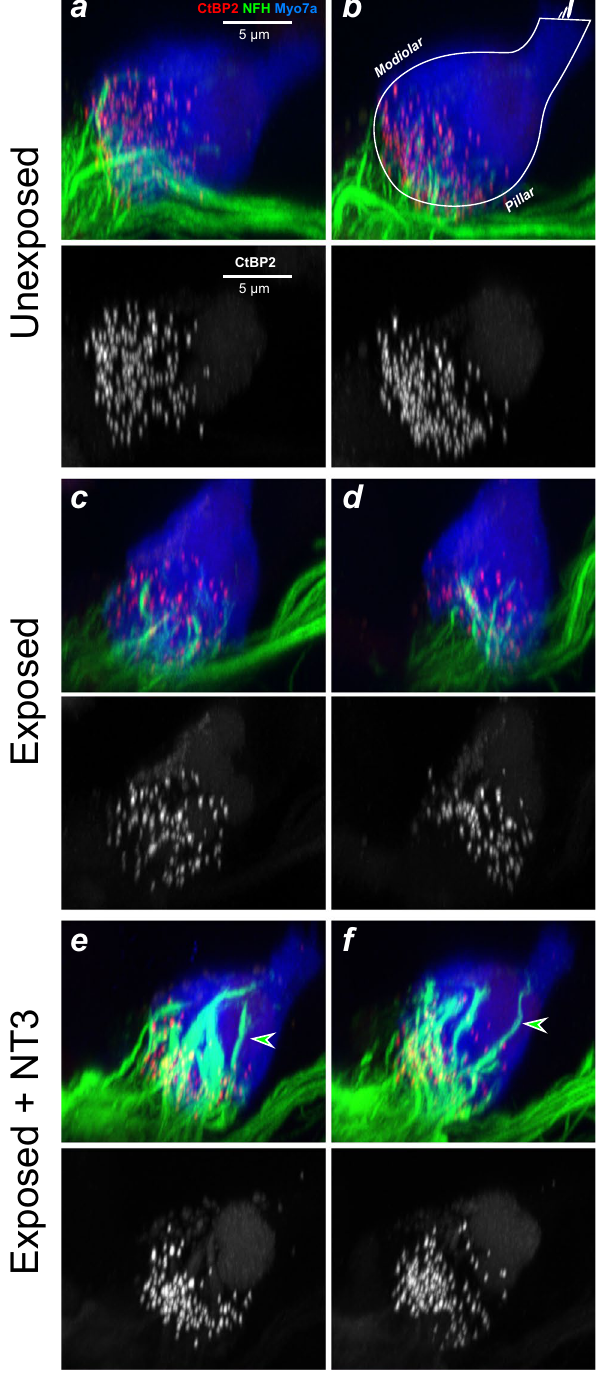
Figure 5. NT3 overexpression reduces synaptopathy and maintains the ribbon-size gradient, but changes location and immunostaining of surviving ANF terminals. Images here are from the 32-kHz region of three animals, from the groups indicated. Each is a re-projection into the yz plane of a confocal z-stack spanning ~10 IHCs (77 μ m) along the cochlear spiral. These yz maximum projections mimic thick cross-sections through the organ of Corti. Each stack is shown as both a 3-color image showing immunostaining of IHCs (Myo7a, blue), ribbons (CtBP2, red), and neurons (NFH, green), and a greyscale image to show just the synaptic ribbons. The white outline in panel b illustrates the orientation of the IHC and its stereocilia bundle in these yz projections (OHCs are to the right). Arrowheads indicate terminals that project farther from the synaptic pole, and appear richer in neurofilaments, than normal. The scale bar in a applies to all